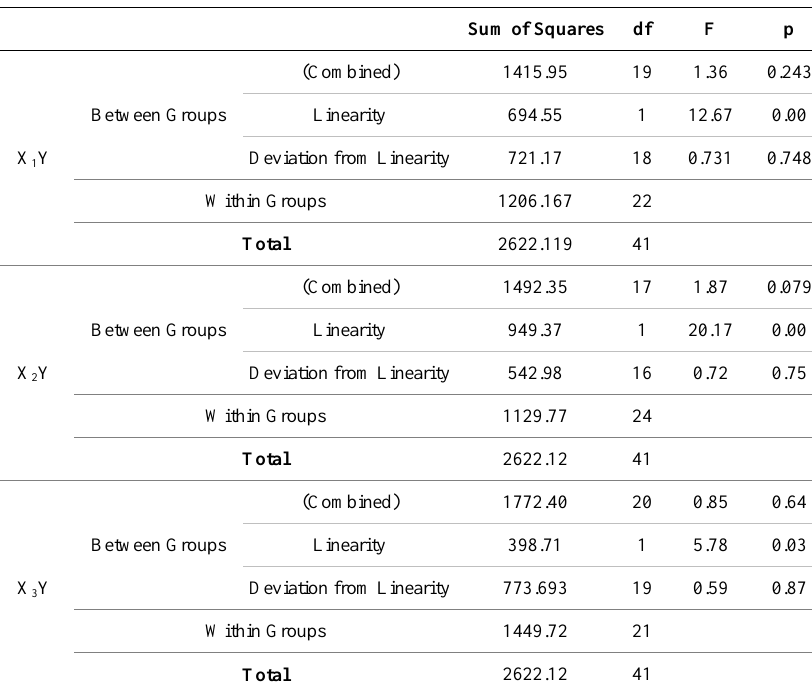
Table 6. Linearity summary